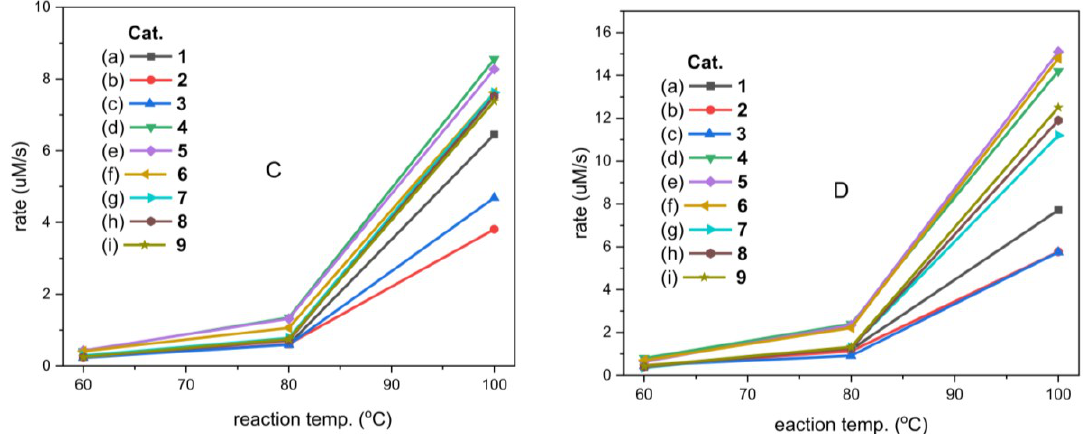
Figure 4. Reaction rate (μM/s) for the catalytic oxidation of ( A ) 0.1 mM of catalyst in neat toluene ([toluene] = 9.39 M); ( B ) 0.2 mM of catalyst in neat toluene ([toluene] = 9.39 M); ( C ) 0.1 mM of catalyst in a reaction solution consisting of 80% of toluene and 20% of 1,2-dichlorobenzene ( v/v ) ([toluene] = 7.51 M); and ( D ) 0.2 mM of catalyst in a reaction solution consisted of 80% of toluene and 20% of 1,2-dichlorobenzene.